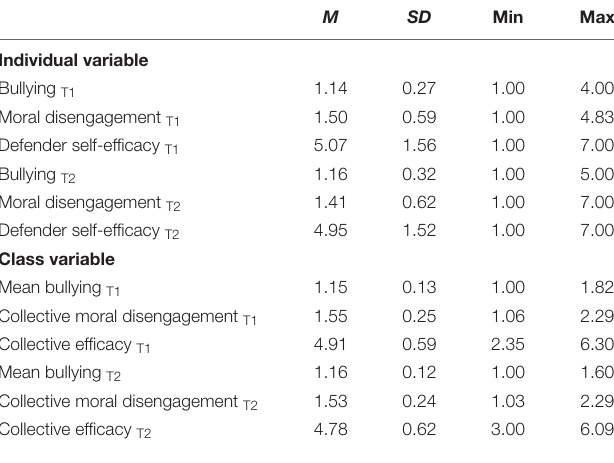
TABLE 1 | Means (M), standard deviations (SD), minimum and maximum observations (Min, Max) for individual- ( N = 1250) and class level ( N = 98)